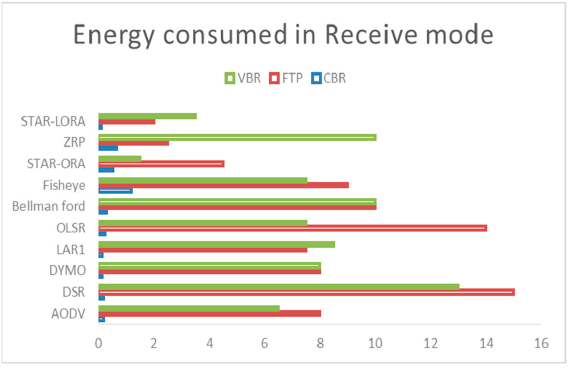
Figure 14. Receive mode energy consumption of all routing protocols for 60 nodes .